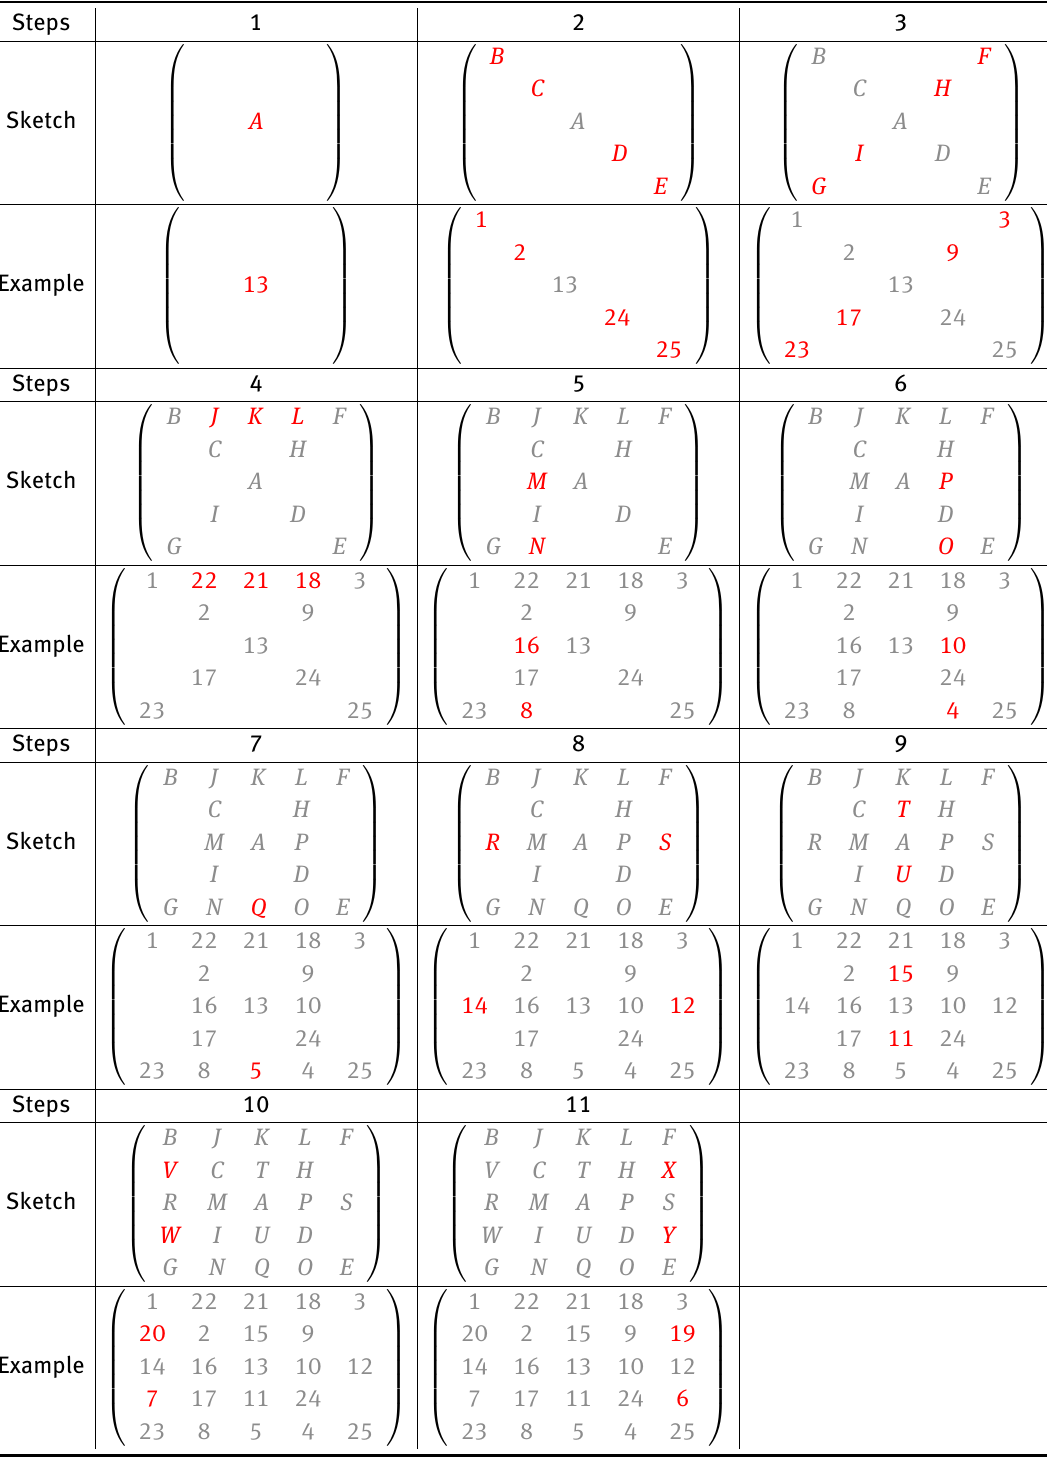
Table 3: Sketch and an example of enumeration algorithm for generating all basic forms of MS- 5 . *Letters and numbers in red color represent the components which are going to be determined at each step, those in grey represent components which have been